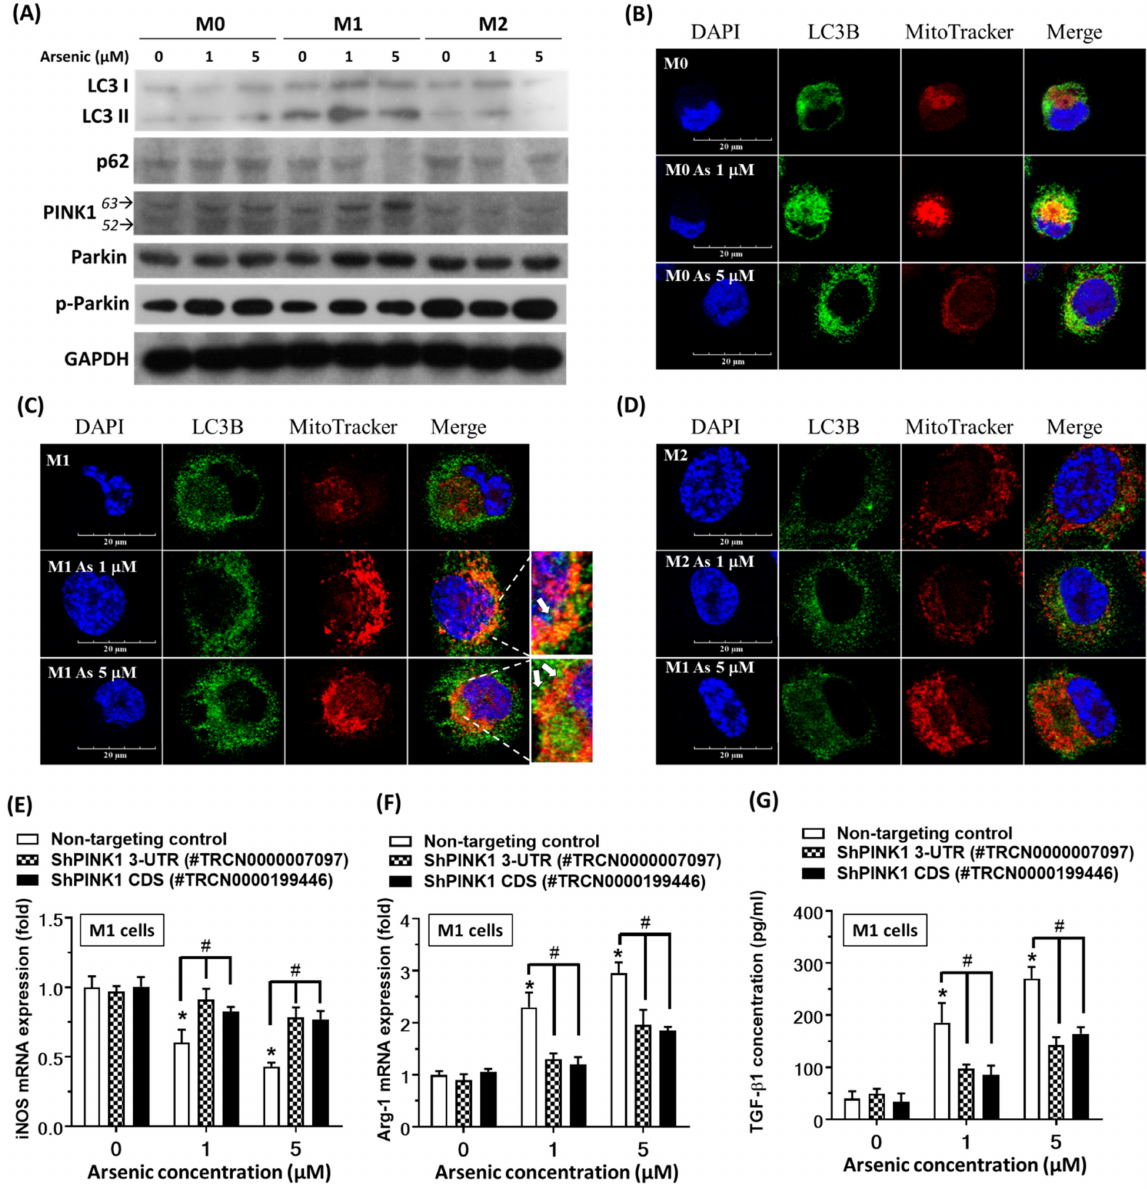
increased, and the number of infiltrated CD206 + cells in lung tissue was increased (Supplementary Figure S1).